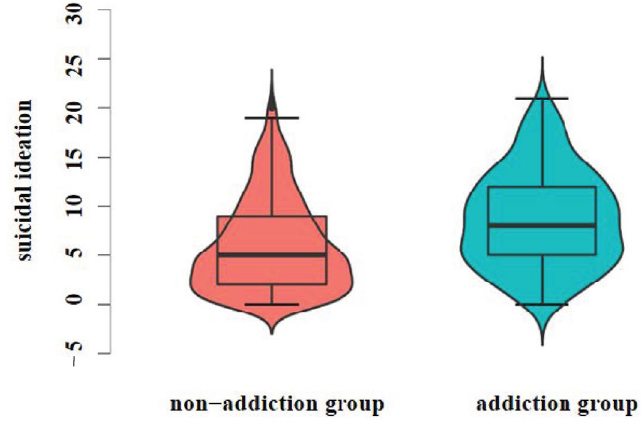
Figure 2. Differences in suicidal ideation between the non-addiction group and addiction group. Table 1. Differences in the main variables by gender and residence ( M ± SD ). Gender Place of Residence